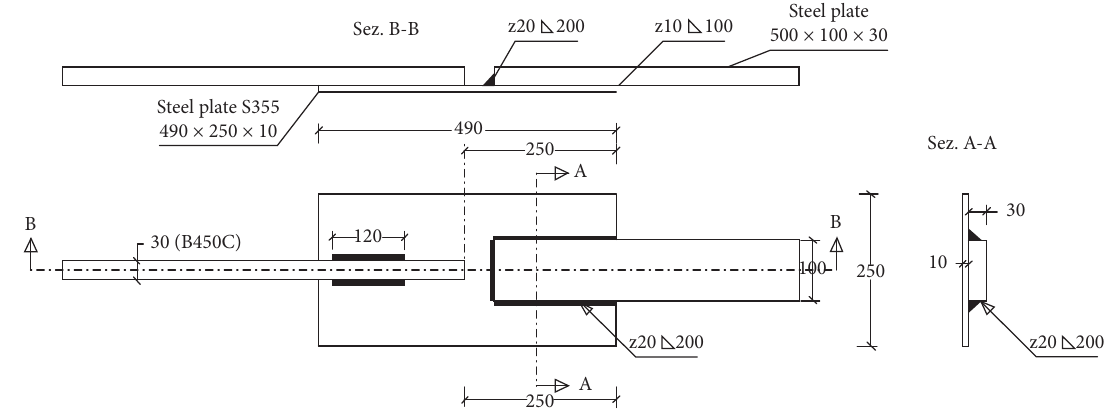
Figure 7: Modification of large-diameter Dub-joint specimens for placing in the experimental test